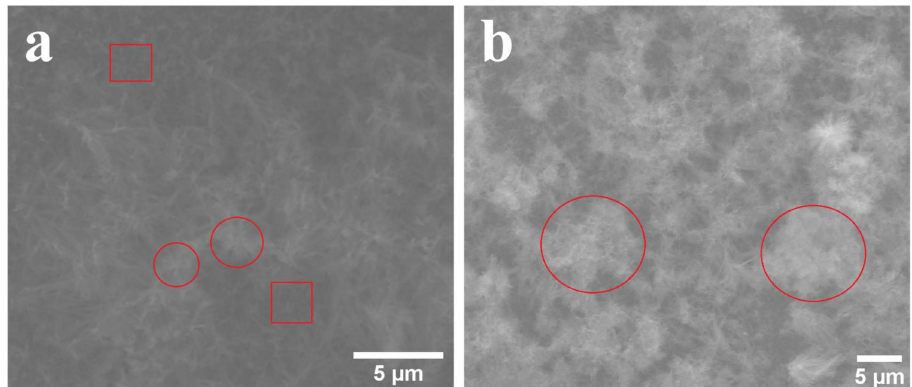
Figure 2. SEM images of samples deposited during 2 h at 80 ◦ C, with ( a ) Ca added to the electrolyte; ( b ) P added to the electrolyte.